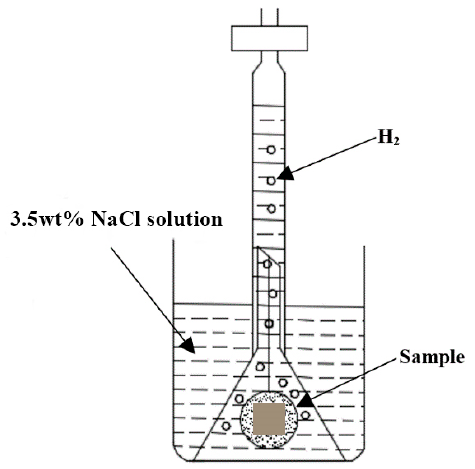
Figure 1. Schematic illustration of hydrogen evolution apparatus.